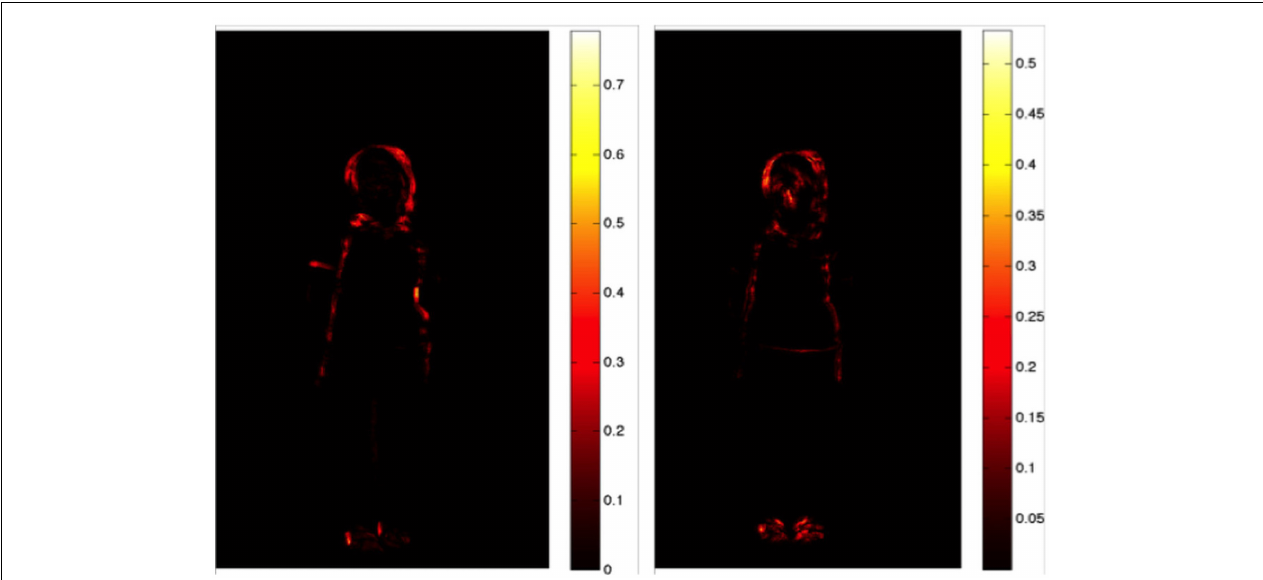
FIGURE 3 | Illustration of the heat maps showing the outline of the body of a girl obtained for a truthful (Left) and a deceptive (Right) sequence in experiment 1. The unit of measure is the average pixel change, meaning that brighter colors indicate larger changes during the video, i.e., more movement.